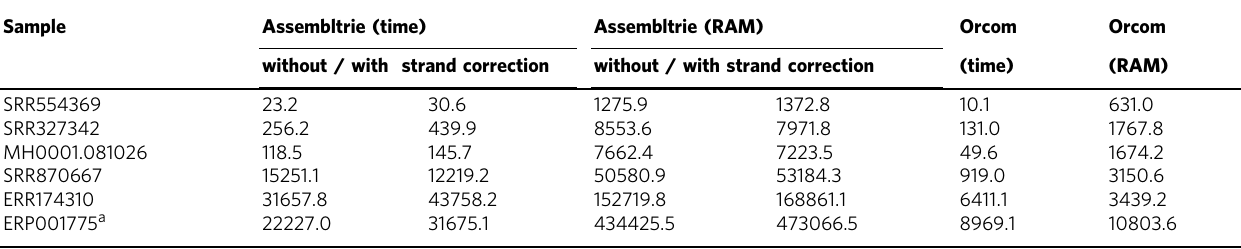
Table 3 Compression times and memory usage of Assembltrie and Orcom